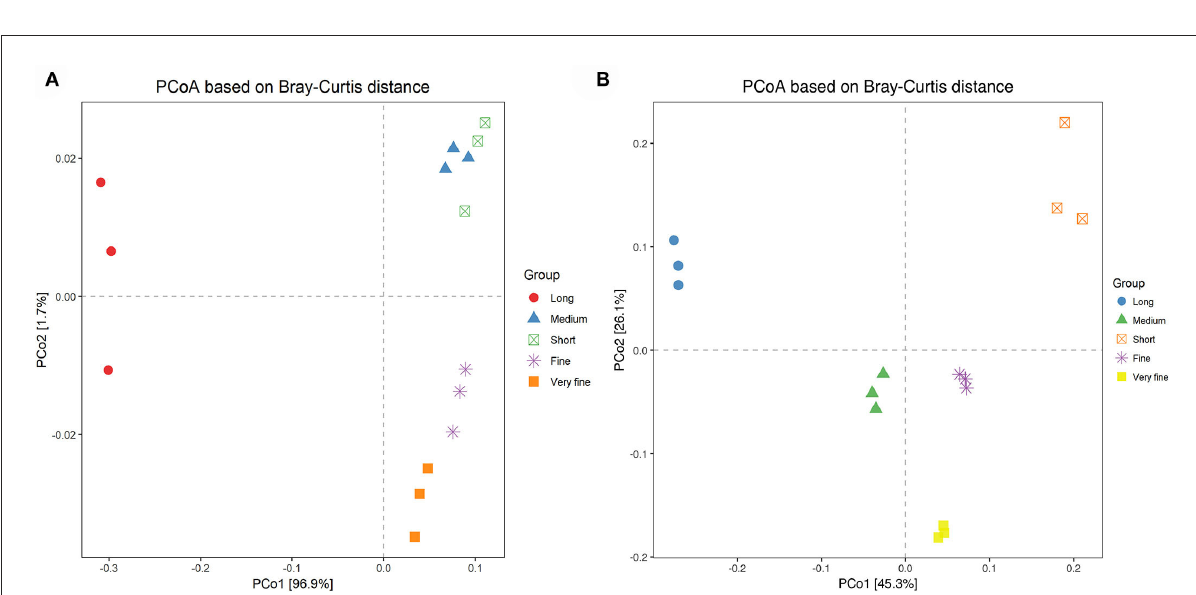
FIGURE2 PCoA analysis based on Brary-Curtis distance among the five treatments of archaea (A) and fungi (B) . Distances between the samples, based on similarity in OTU composition (OTU similarity ≥ 97%) calculated with Brary-Curtis distance, were visualized by principal coordinates analysis (PCoA) plots. A greater distance between two samples inferred a lower similarity. The percentage of variation explained by PC1 and PC2 were indicated in the axis.